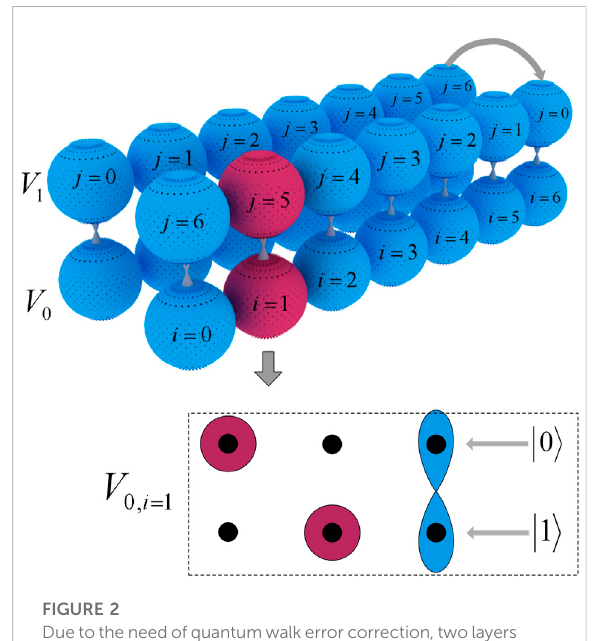
Duetotheneedofquantumwalkerrorcorrection,twolayers of network lattice ( V 0 and V 1 ) are set in the Bose – Hubbard mode. In the 3D fi gure, the left side represents the original two- dimensional lattice diagram, and the right side represents the lattice encoded by using the Yang diagram method in V 1 , where the lattice position in V 0 remains unchanged. The following 2D diagram describes the encoding mode of the particles in the